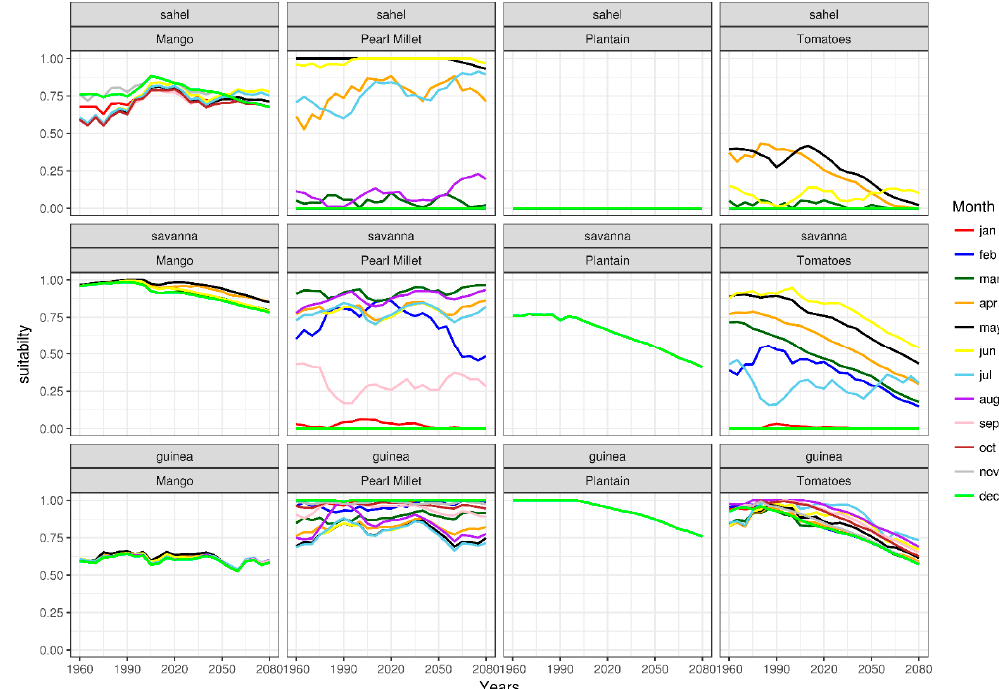
Figure 9. Projected model ensemble suitability over West Africa between 1960–2100 for mango, pearl millet, plantain, and tomatoes.